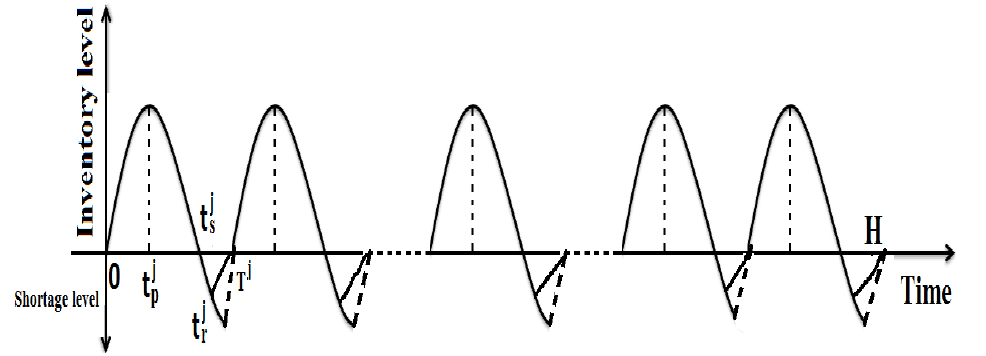
Figure 1. Inventory behavior of the first N j